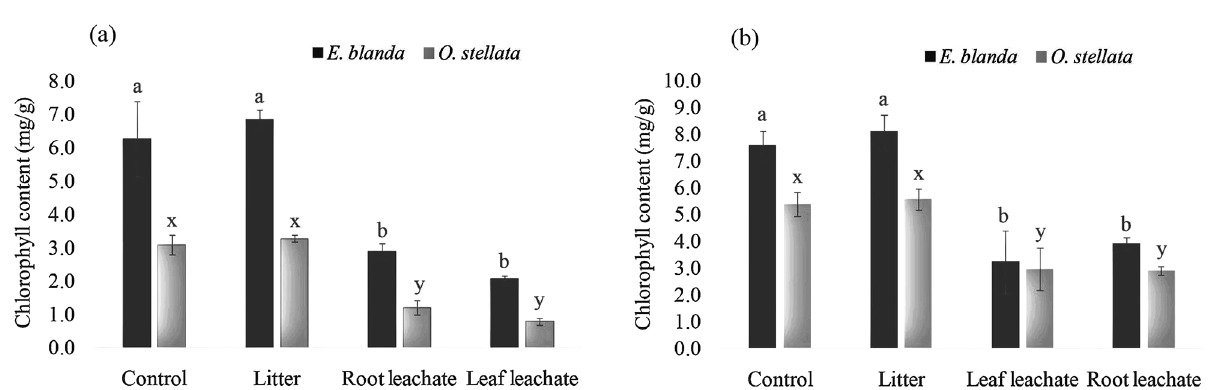
Figure 3. Effect of A. adenophora leachates on ( a ) chlorophyll - a and, ( b ) chlorophyll - b of native E. blanda and O. stellata. Different letters above the error bar indicate significant differences among the treatments (‘a’, ‘b’, and ‘c’ for E. blanda ; and ‘x’, ‘y’, and ‘z’ for O. stellata; p <